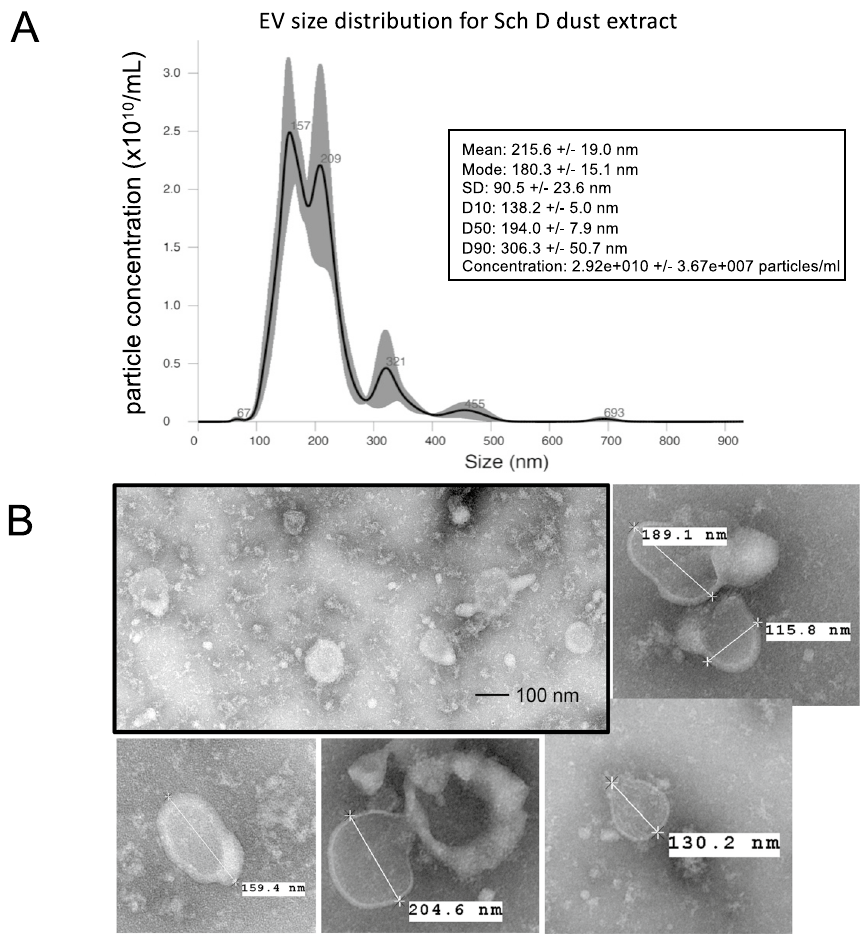
Figure 1. EVs are abundant in DE-derived dust samples. Nanoparticle tracking analysis of 100% DE-derived EVs indicated a concentration range of 2.5–3.8 × 10 10 particles/mL and a mean size of 215 nm ( A ). Representative transmission electron micrographs illustrate the concentration and size distribution of EV preps ( B ). In all subsequent experiments the Sch D DE-derived EVs were